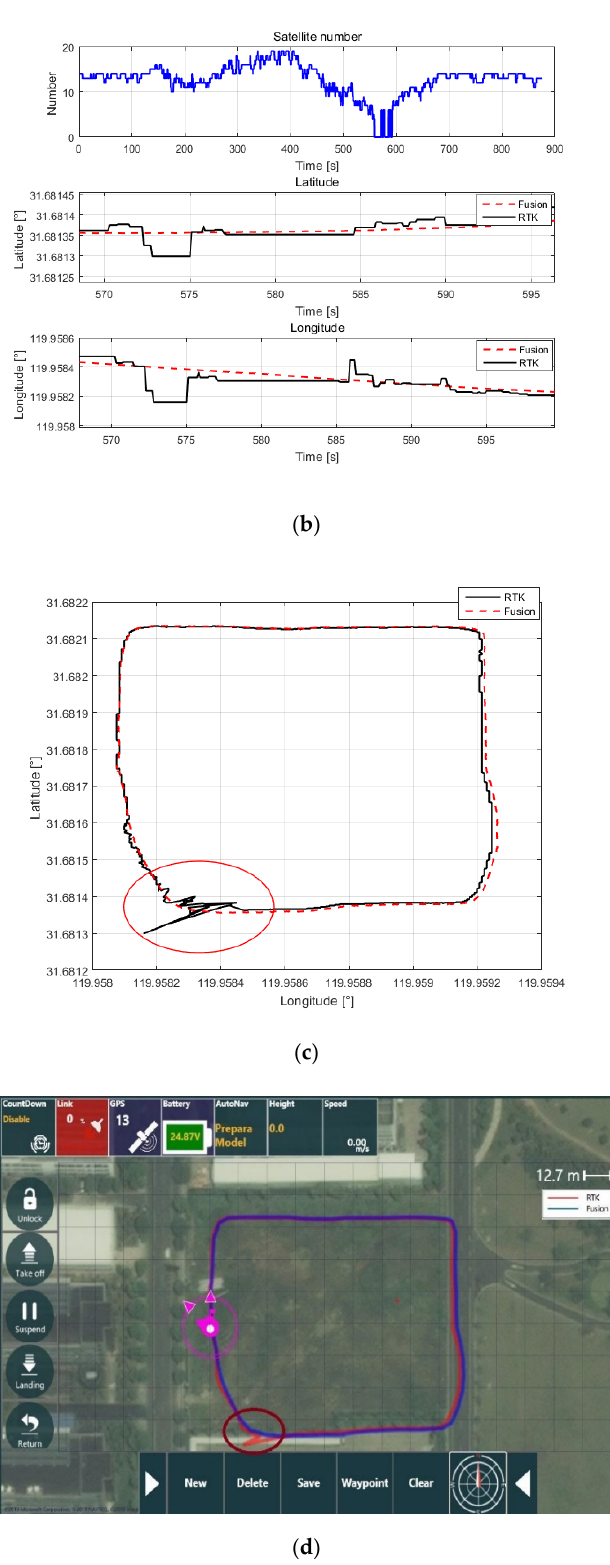
Figure 8. The flight trajectory of the UAV near high-rise buildings. ( a – c ) A comparison of the traces displayed in MATLAB. The red dashed line represents data from the fusion-based system, and the black line represents the ground truth, which was provided by the RTK system; ( d ) A comparison of the trajectories of the UAV via the station on the ground. The blue line represents the data from the fusion-based system, and the red line represents the ground truth provided by the RTK system.